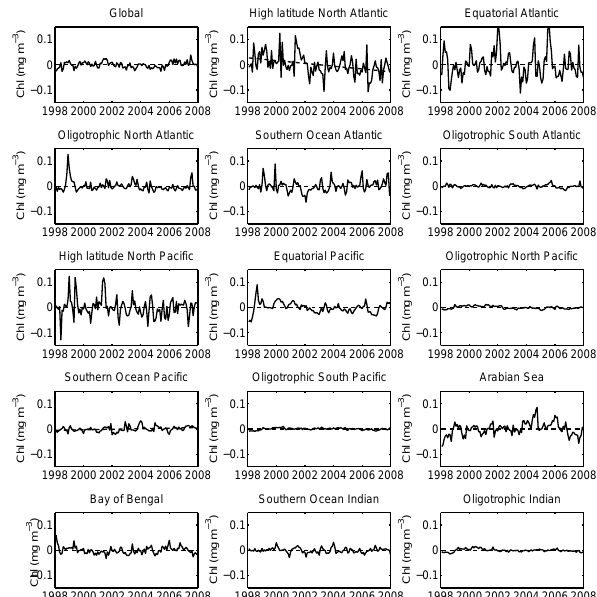
Fig. A1. SeaWiFS ocean chlorophyll concentrations anomalies from 1998–2007 averaged globally and in 14 biomes. The dotted lines represent the